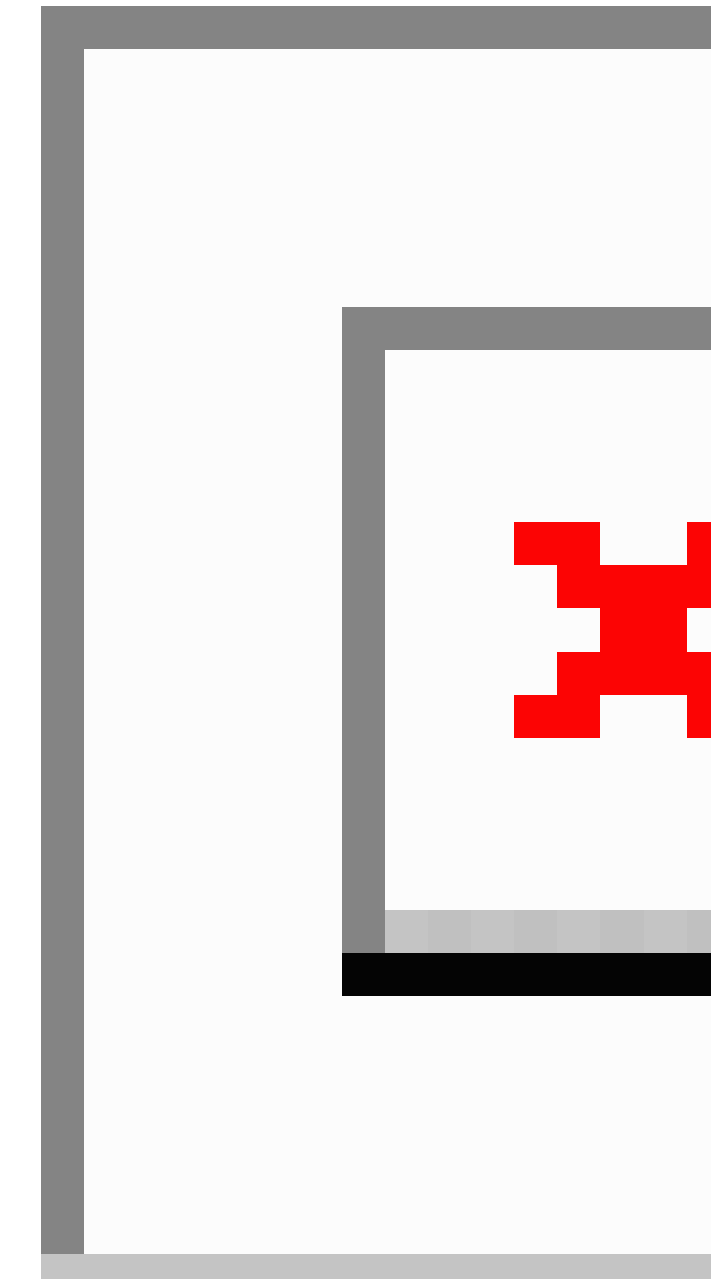
Figure 7. Overview of platform demographics of Facebook and smartphone application